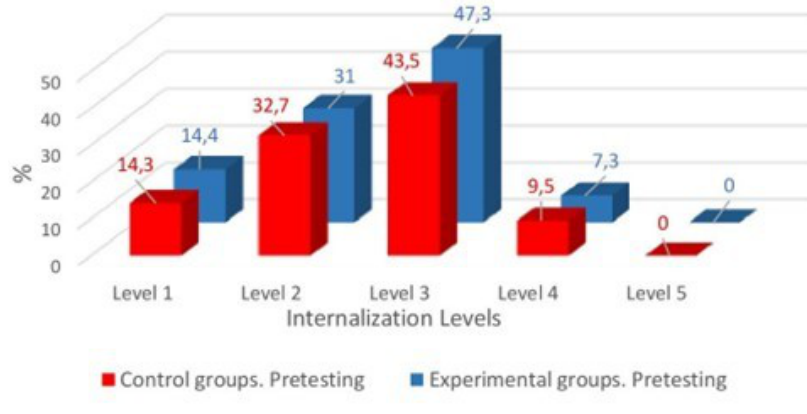
Figure 1 - The ascertaining stage of internalized social activity